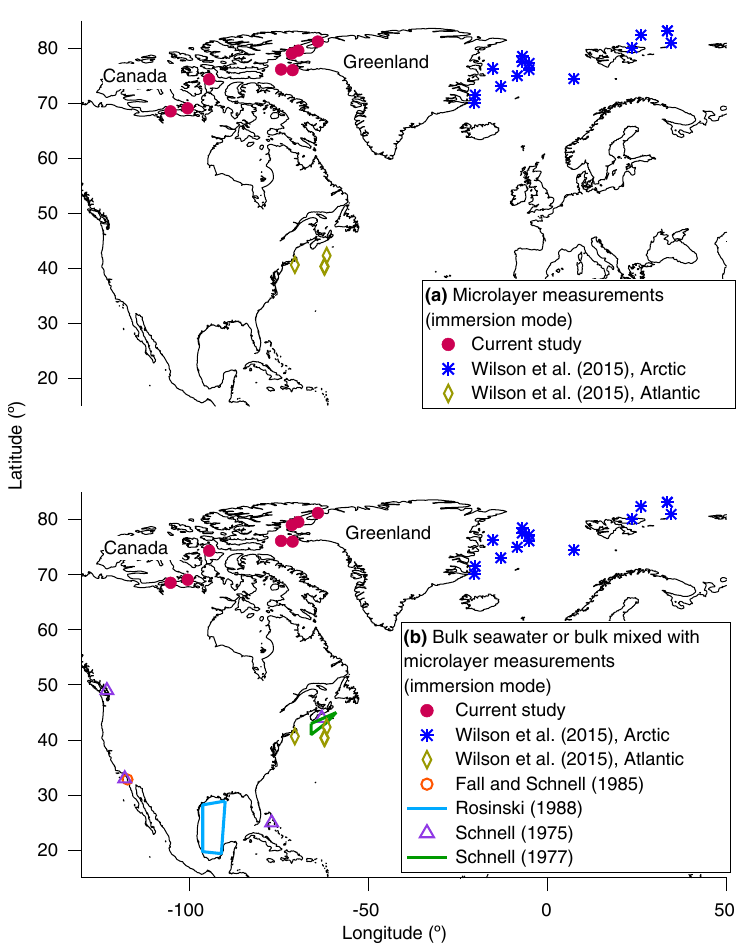
Figure 1. Panel (a) shows locations of current and previous studies of INPs (immersion mode) in the microlayer. Panel (b) shows locations of current and previous studies of INPs (immersion mode) in bulk seawater or mixtures of bulk seawater and the microlayer. Dates and coordinates for samples in the current study can be found in Table